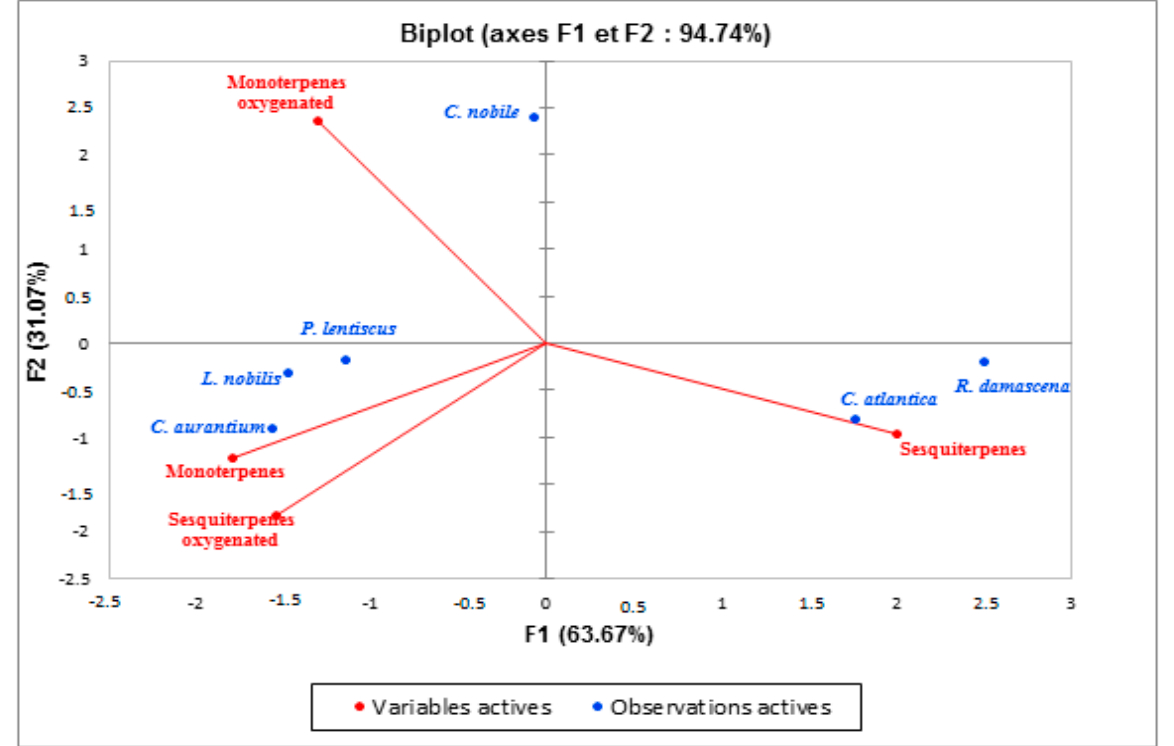
Figure 4. Principal component analysis carried out on the main chemical families of EOs of the species studied.